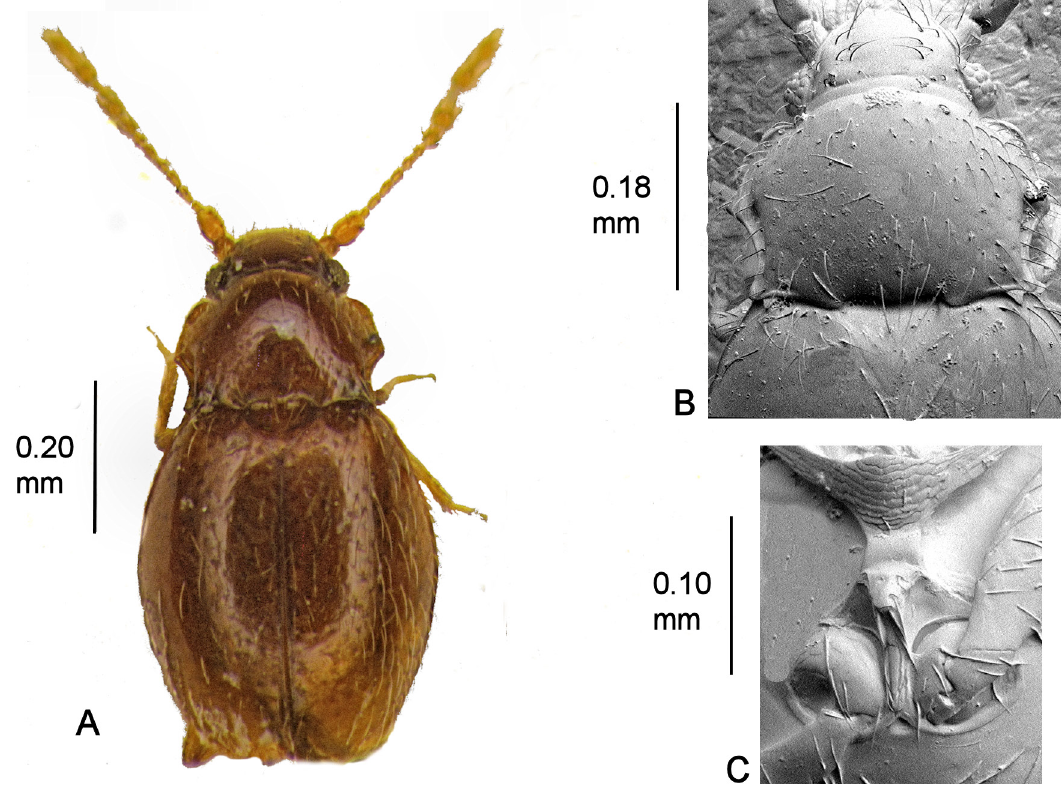
Fig. 91 . Cissidium dividuum sp. nov. A . Habitus. B . Pronotum, × 495. C . Mesoventrite showing median process of collar, mid-keel and keel,